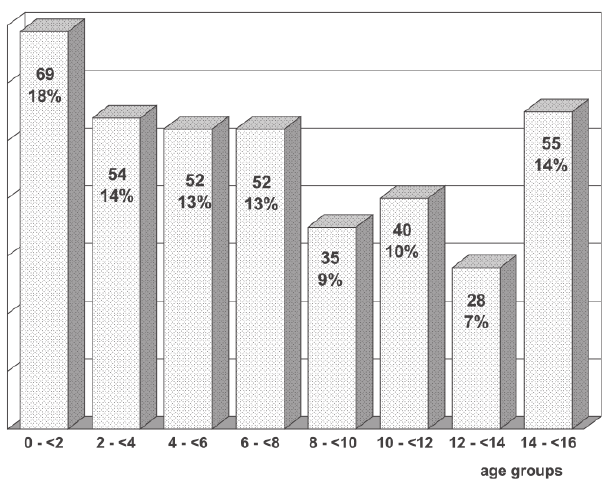
Figure 1 - Distribution of included patients according to